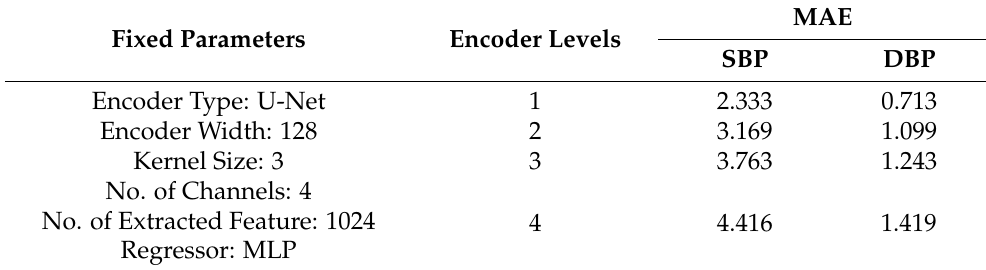
Table 5. Mean absolute error (MAE) of BP prediction for variable encoder depth.